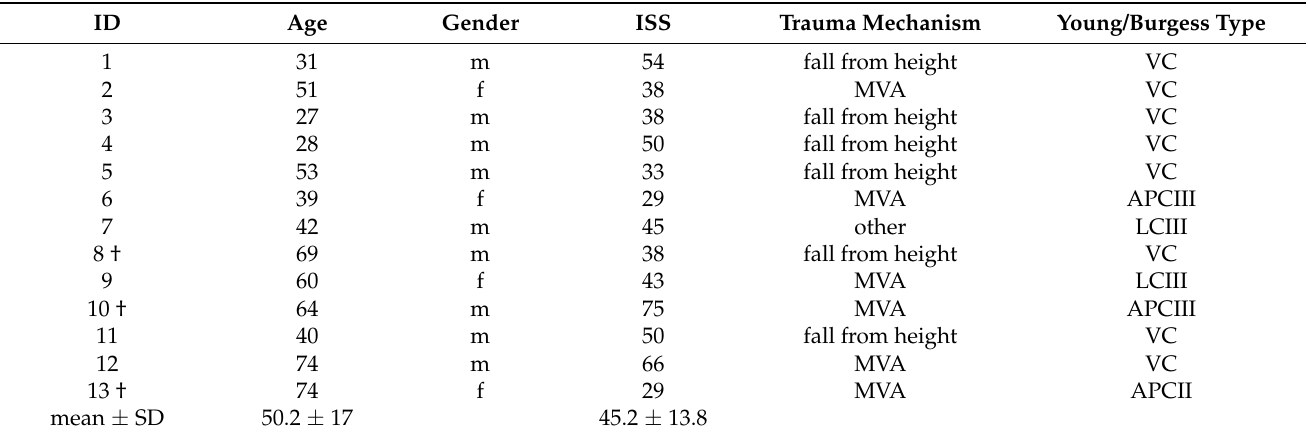
Table 1. Age, gender, injury severity score, trauma mechanism, and fracture classification in patients with unstable pelvic ring fractures with hemodynamic instability and treated by C-clamp application.